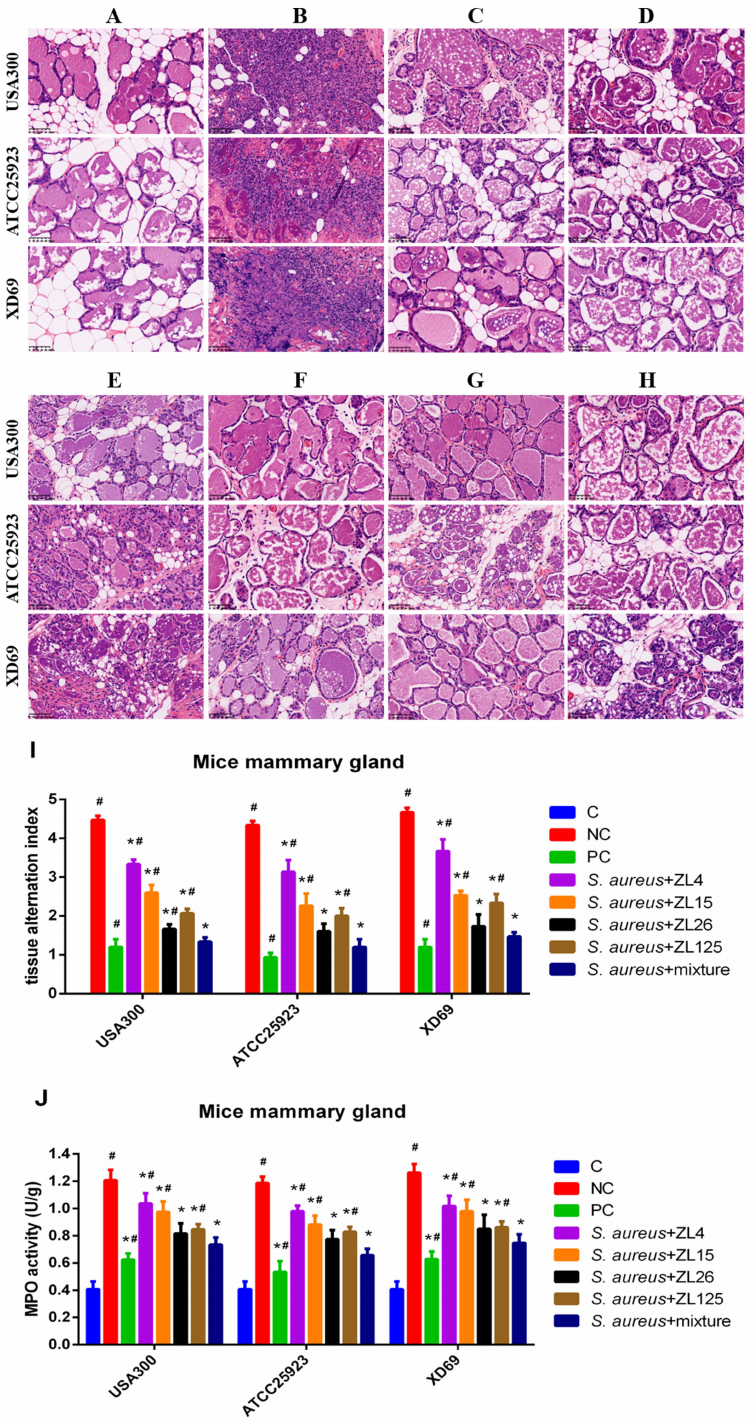
Figure 7. Functions of scFvs on histopathological changes in S. aureus -induced mammary gland tissues by H & E staining. ( A ) Control group; ( B ) negative control group; ( C ) positive control group; ( D ) scFvs mixture group; ( E – H ) single scFv group (ZL4, ZL15, ZL26 and ZL125, respectively); ( I ) Tissue alteration index in mammary gland tissues; ( J ) MPO activity assay. Red arrow was tissue lesion area (red arrow indicates inflammatory cells infiltration in mammary gland tissues). Data represent mean results ± SD ( n = 6). # p < 0.05 vs. scFvs mixture group. * p < 0.05 vs. negative control